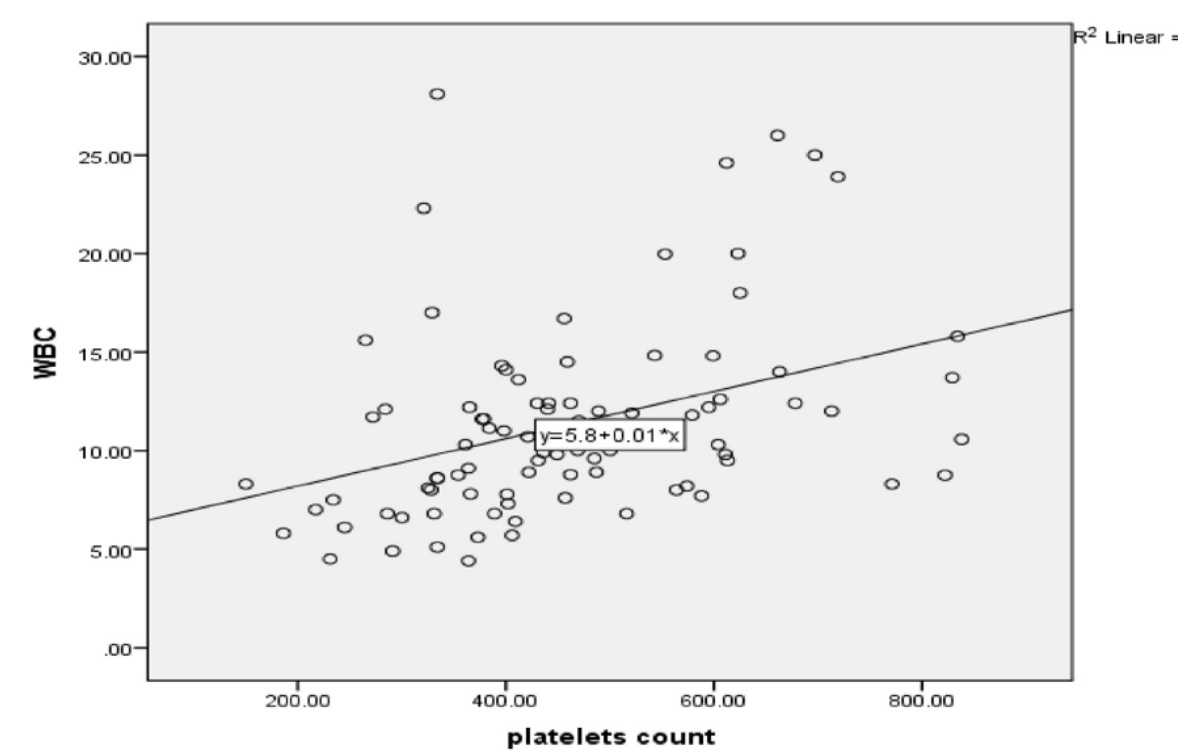
Figure 5. Showing the correlation between WBC and platelets count in IgA vasculitis cases. non-steroidal anti-inflammatory drugs, were prescribed for 28 patients (31.5%). Oral prednisolone in a dose of 1–2 mg/kg was prescribed for 21 cases (23.6%) for 2 weeks before being tapered for 2 weeks.